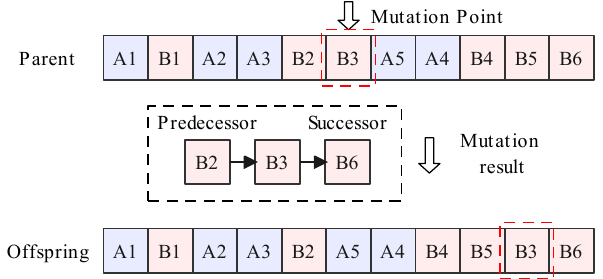
Figure 5. Operation process of single-point insertion